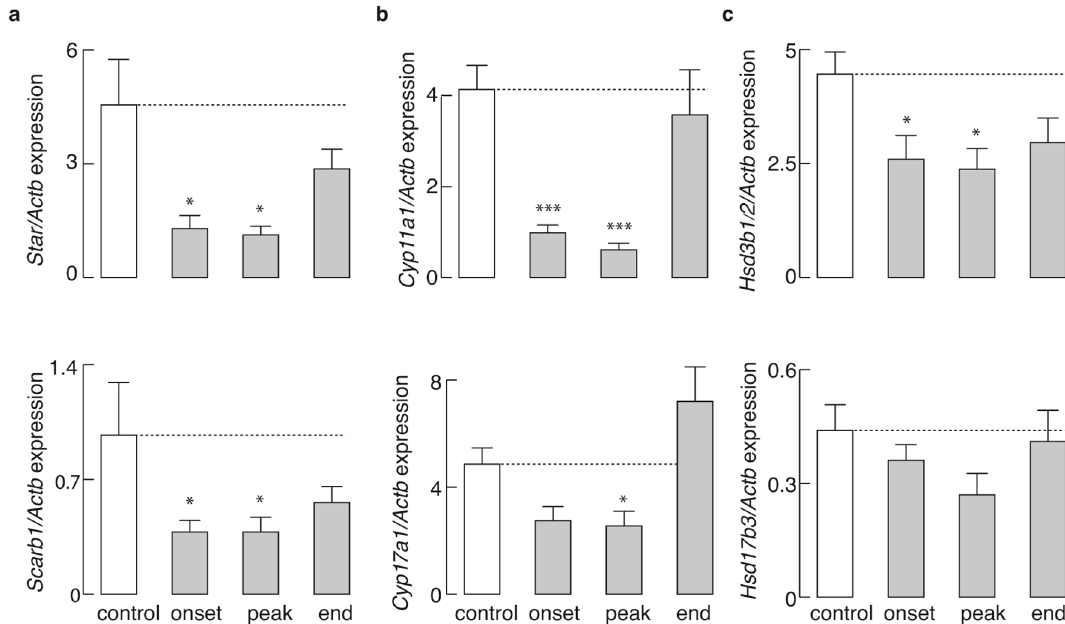
Figure 2. Effects of EAE on the expression profile of steroidogenic pathway genes in testicular interstitial cells. Samples isolated from interstitial cells of animals at different stages of disease and control animals (n = 6 animals /group) were subjected to qRT-PCR analysis: Star ( a top), Scarb1 ( a bottom), Cyp11a1 ( b top) Cyp17a1 ( b bottom), Hsd3b1/2 ( c top) and Hsd17b3 ( c bottom). Plotted data are presented as mean ± SEM; * P < 0.05,